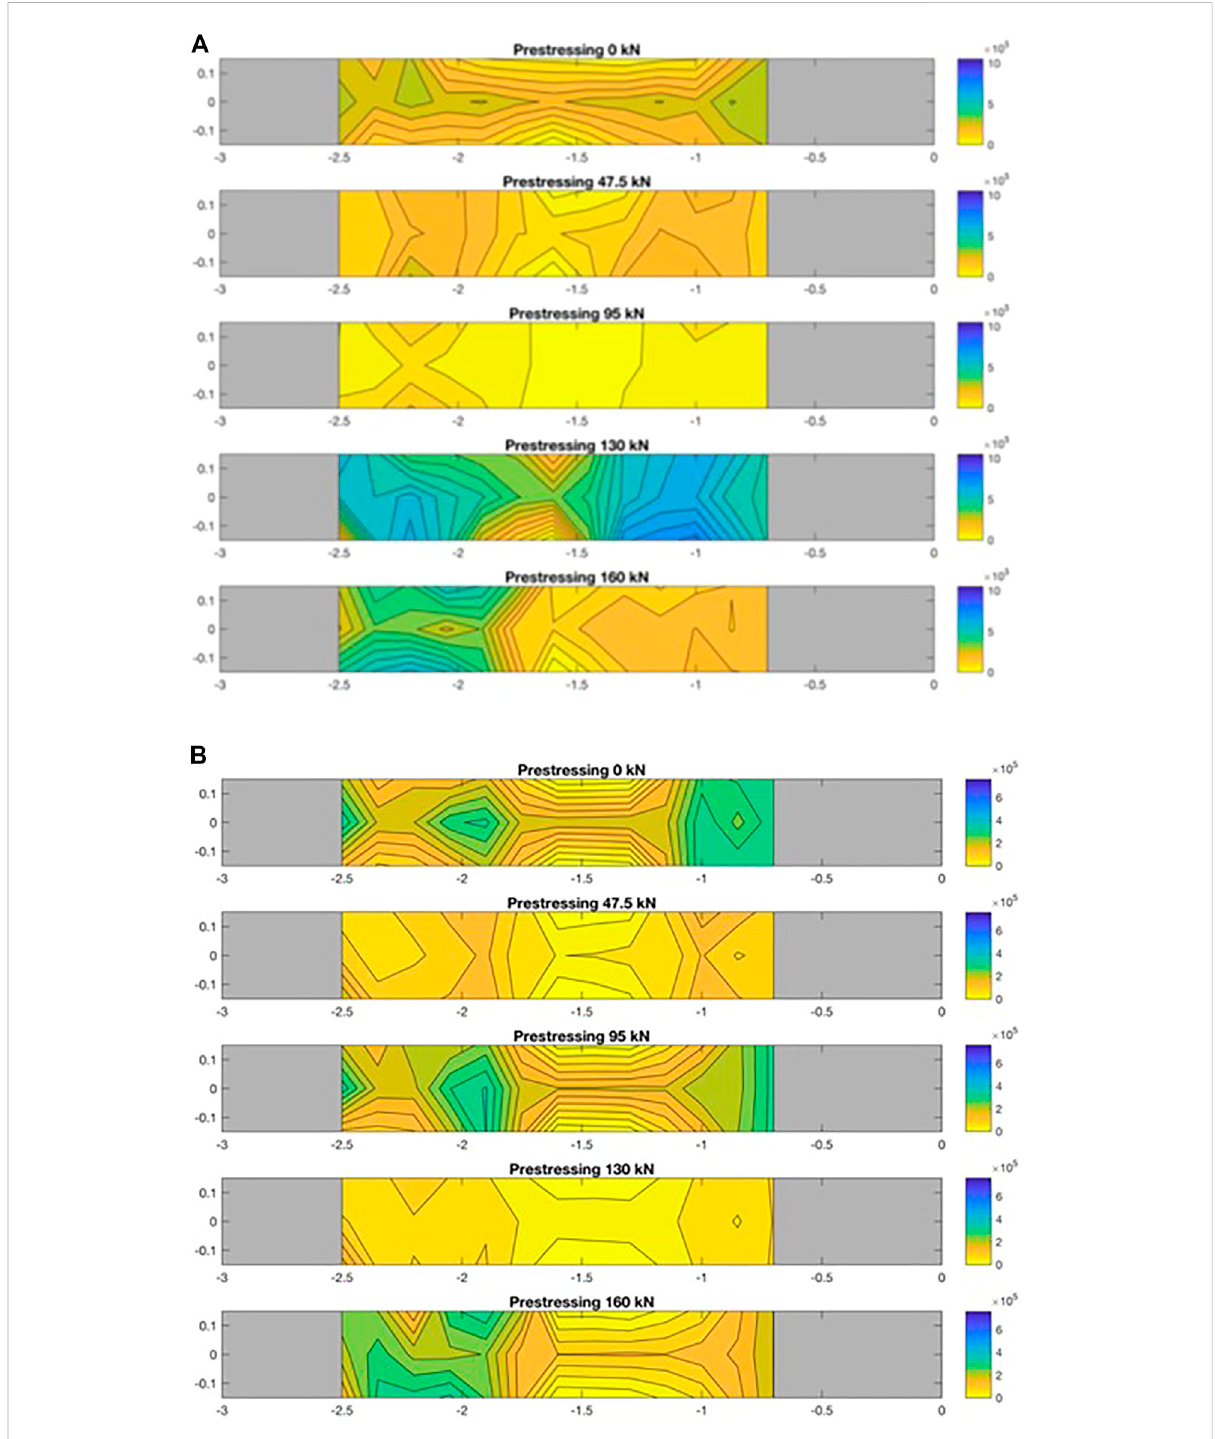
FIGURE 7 UPVattenuation(m/s)inthevertical direction (PTCcross-section height=0.3 m)ofBeam1in (A) undamagedconditionand (B) aftercomplete